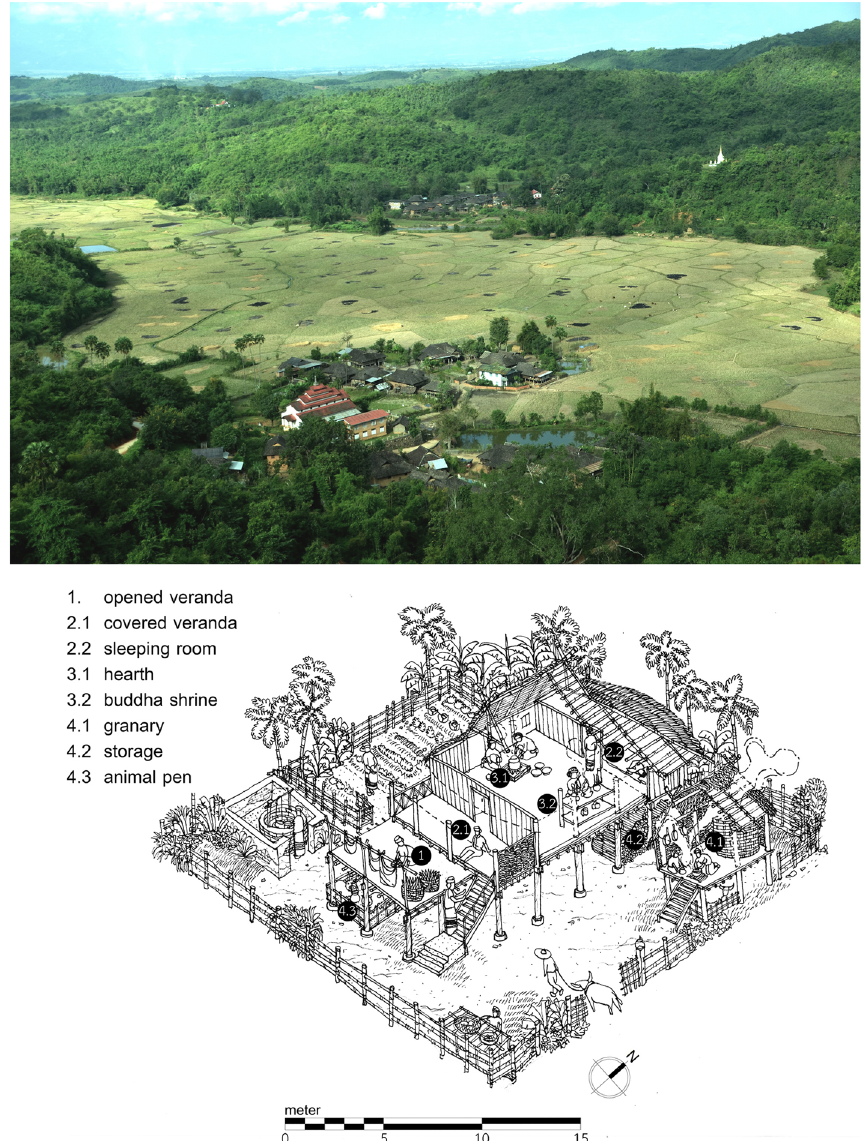
Fig. 2 Top: a Dai settlement. Bottom: sketch of a Dai settlement in Shan State Myanmar (Source: Oranratmanee